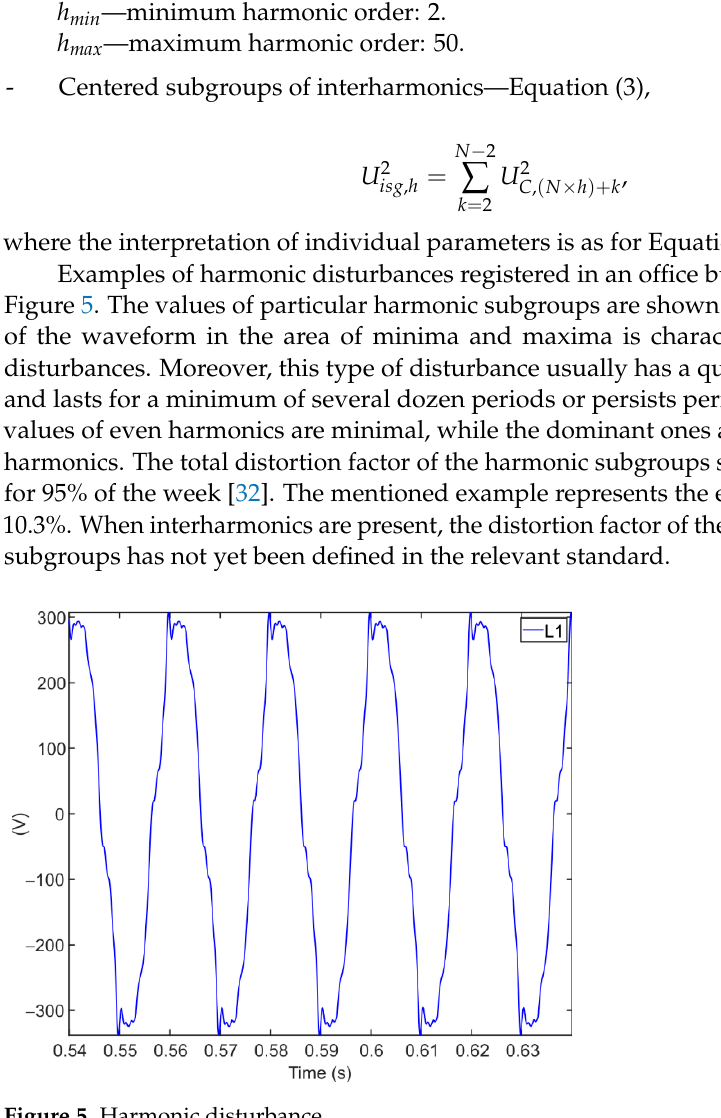
Figure 5. Harmonic disturbance. Table 2. Parameters of measured harmonics from THDS U = 10.3%.